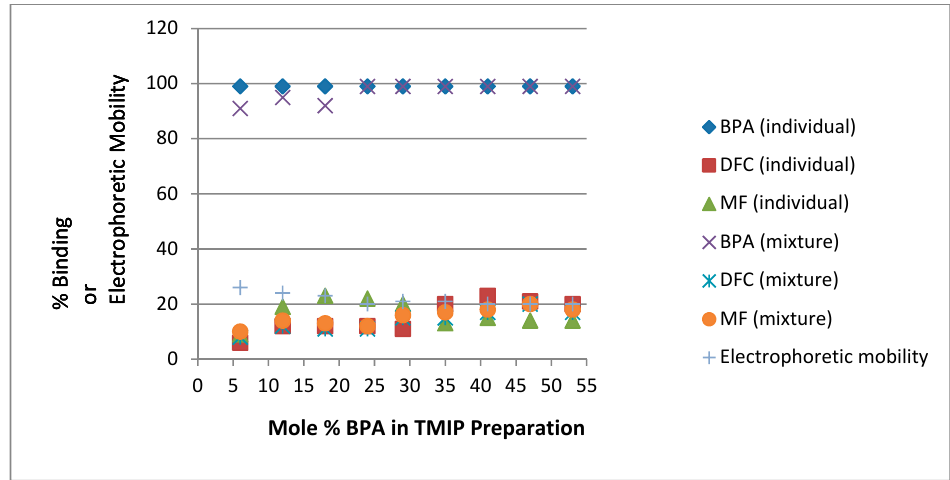
Figure 2. Percent binding results of BPA, DFC and MF (individually and in mixture) and electrophoretic mobility for each diazomethane-treated molecularly imprinted polymers (TMIP) prepared with a different mole % of BPA. For clarity, error bars are represented by the size of symbols.